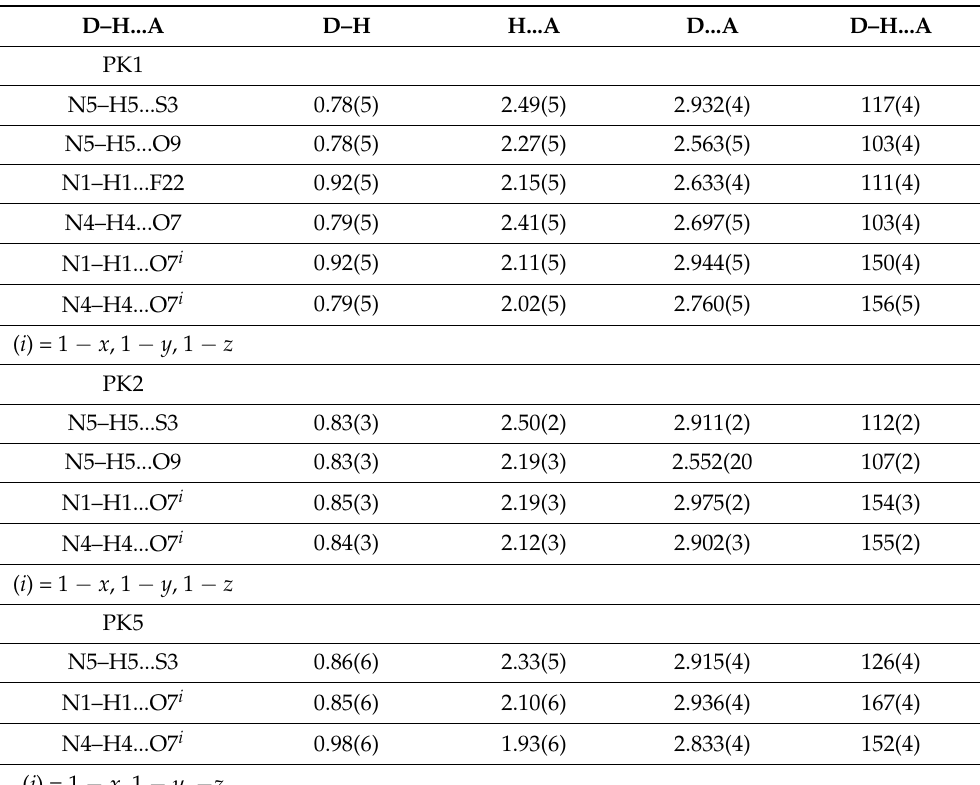
Table 3. Hydrogen-bond geometry (Å, ◦